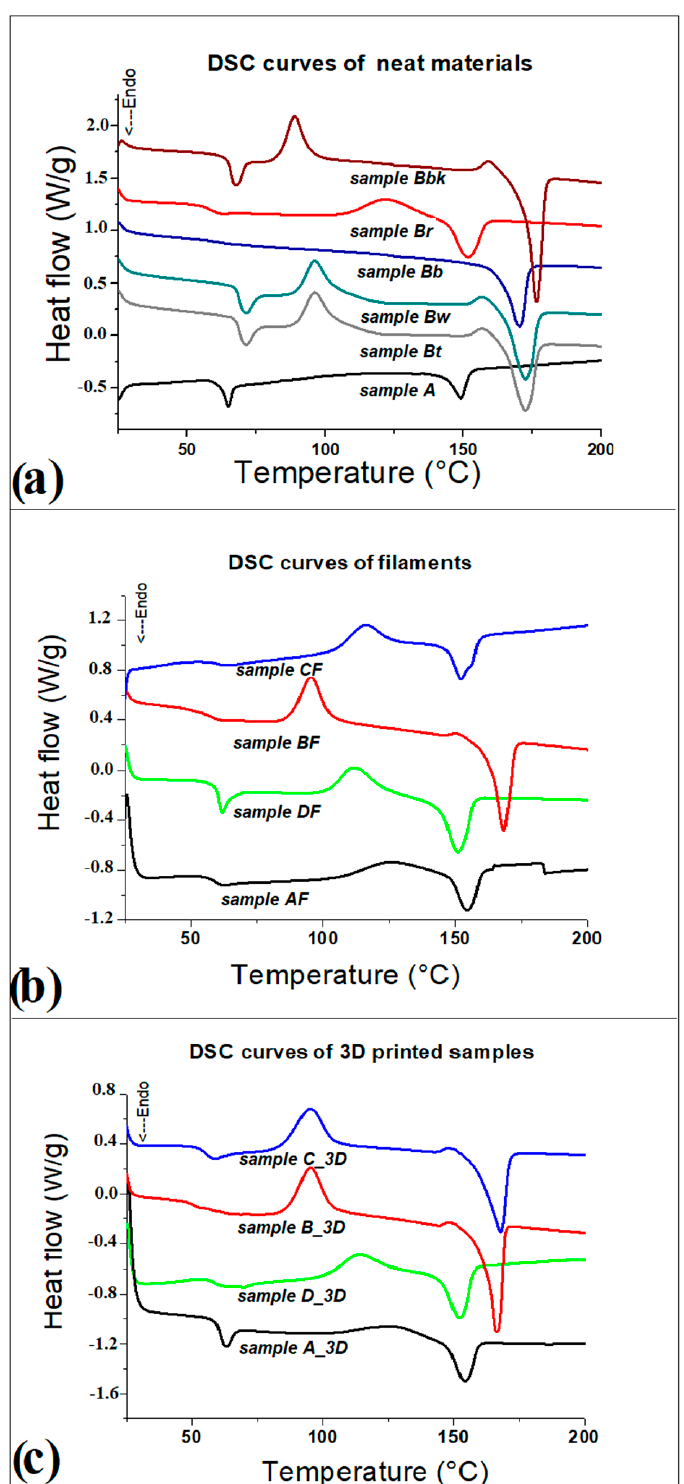
Figure 3. DSC thermograms of the samples: ( a ) polymeric neat materials; ( b ) filaments; ( c ) 3D printed samples.